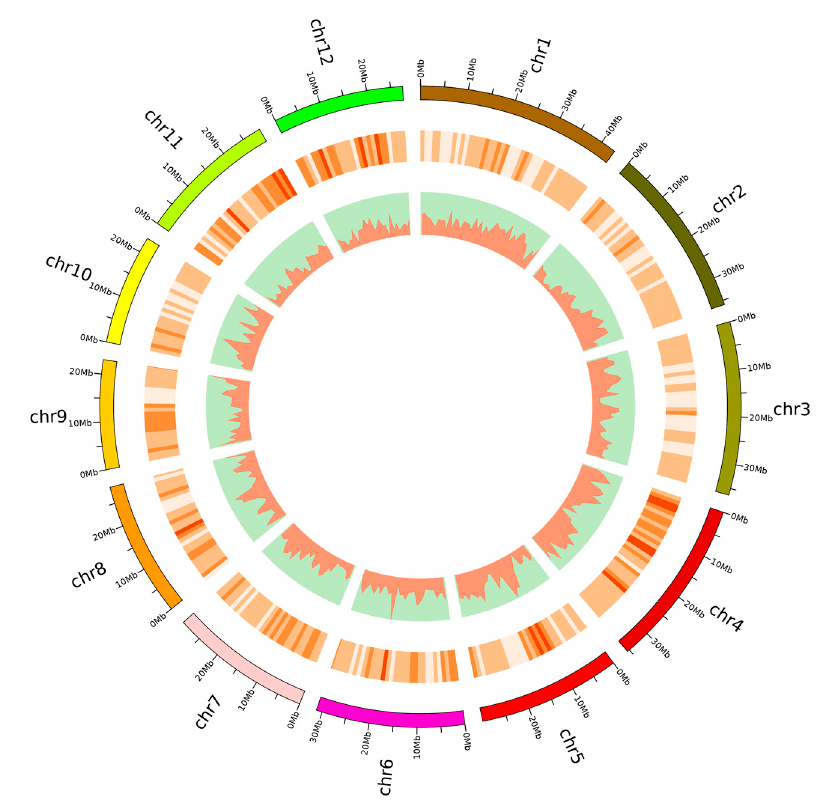
Figure 1. Display of single-nucleotide polymorphism (SNPs) identified in the population. The rings from outside to inside indicate the individual chromosomes, SNP distribution, and genomic GC distribution. SNPs were calculated by 1000 kb sliding window across each chromosome.